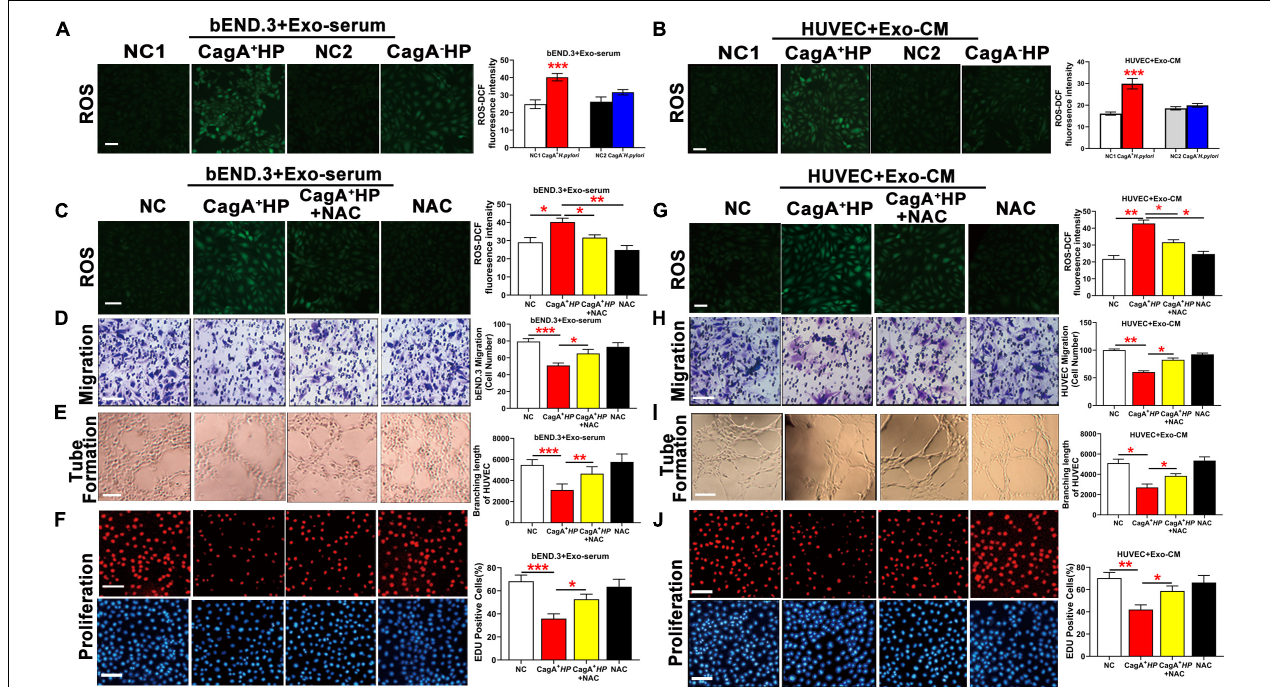
FIGURE 5 | CagA-containing exosome impaired endothelial function via increased ROS formation. (A) Representative fluorescent images and quantification of ROS formation in bEND.3 co-cultured with serum exosomes from mice infected with CagA + H. pylori , CagA − H. pylori or PBS. Intracellular ROS formation was significantly increased in bEND.3 co-cultured with serum exosomes from mice infected with CagA + H. pylori , not from mice infected with CagA − H. pylori or PBS. (B) Representative fluorescent images and quantification of ROS formation in HUVECs co-cultured with exosomes from conditioned media of GES-1 cultured with CagA + H. pylori , CagA − H. pylori or PBS. Intracellular ROS formation was significantly increased in HUVECs co-cultured with exosomes from GES-1 cultured with CagA + H. pylori , not from GES-1 co-cultured with CagA − H. pylori or PBS. NAC treatment significantly decreased intracellular ROS production and preserved endothelial function of bEND.3 (C–F) and HUVECs (G–J) treated with CagA-containing exosomes. NC(1/2): normal control; Exo-serum: exosomes from mouse serum; Exo-CM: Exosomes from conditioned medium; CagA + HP: CagA + H. pylori ; CagA − HP: CagA − H. pylori .; NAC: N-acetylcysteine. Data were presented as mean ± SEM; * P < 0.05; ** P < 0.01; *** P < 0.001 by t -test or one-way ANOVA. Experiment was repeated 3 times for every measurement. Scale bars (all, except for D,H,E ) = 100 µ m. Scale bars (D,H) = 25 µ m. Scale bars (E) = 10 µ